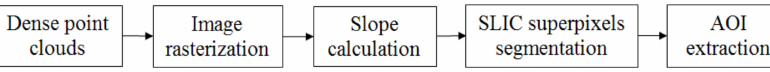
Figure 6. Area of interest (AOI)